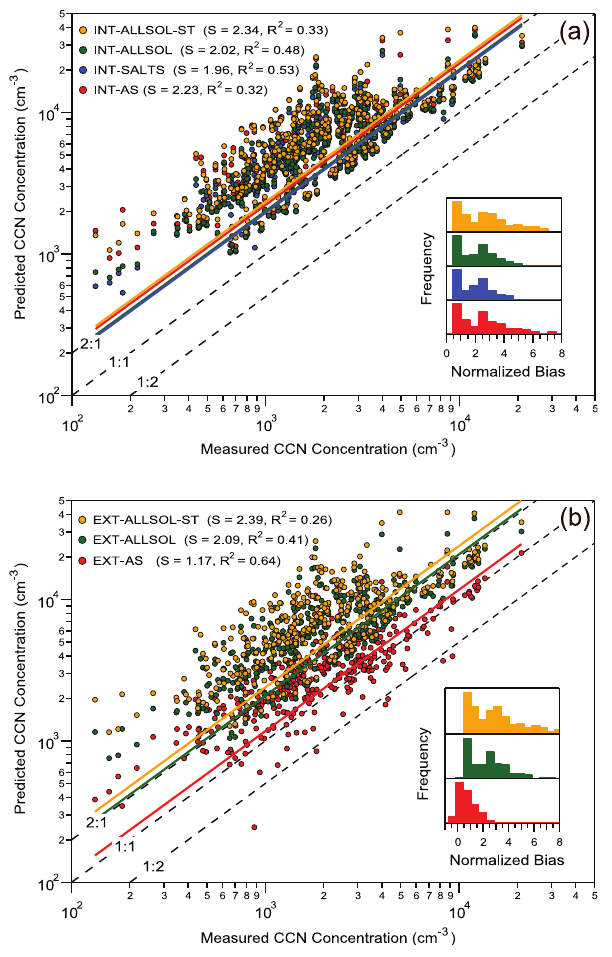
Fig. 7. (a) CCN closure plot for the internal mixture (INT) sce- narios. The red, blue, green, and yellow circles correspond to the INT-AS, INT-SALTS, INT-ALLSOL, and INT-ALLSOL-ST cases (Table 1), respectively. (b) CCN closure plot for the external mix- ture (EXT) scenarios. The red, green, and yellow circles correspond to the EXT-AS, EXT-ALLSOL, and EXT-ALLSOL-ST cases, re- spectively. Inset plots show the observed frequency distribution of the normalized mean bias = ( P i − O i )/ O i .